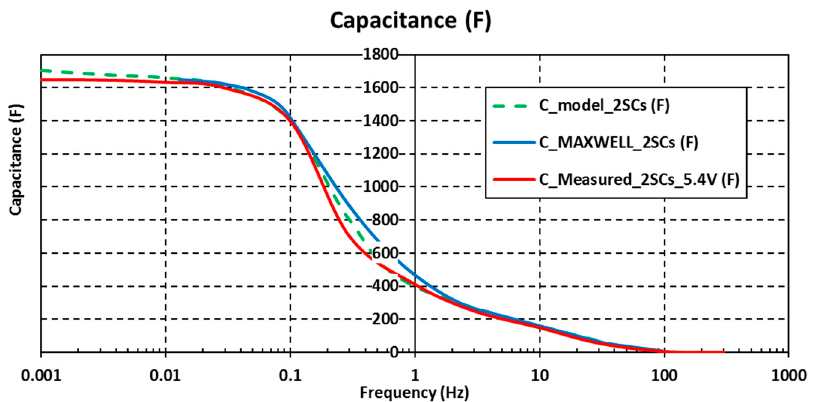
Figure 16. Capacitance value comparison in the frequency response of the electrical circuit (in green) and the obtained value from the experimental tests (in red). Data provided by the manufacturer is also plotted (in blue).